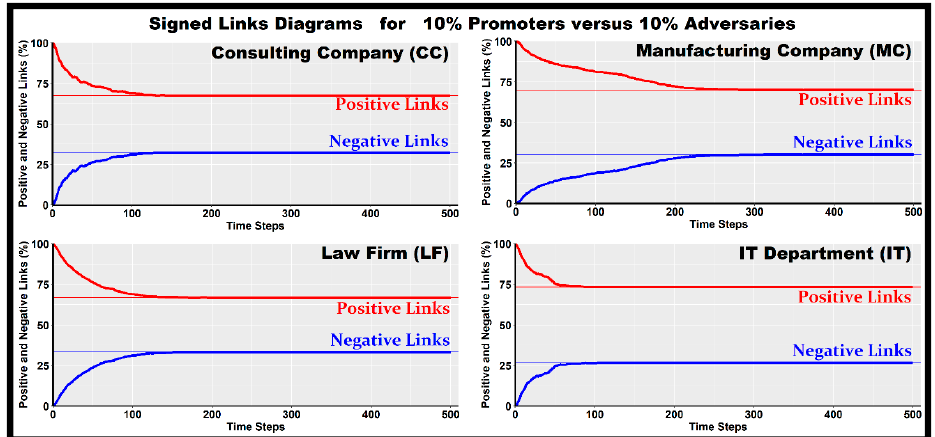
Figure 4. Signed Links Diagrams for the 4 real organizational networks. Both promoters and adversaries have high centrality and the learning rate ℓ is 40% (Table 3). The number of promoters versus adversaries is 10% versus 10%. The blue horizontal line indicates the percentage of Final Positive Links (FPL) . The red horizontal line indicates the percentage of Final Negative Links (FNL) .